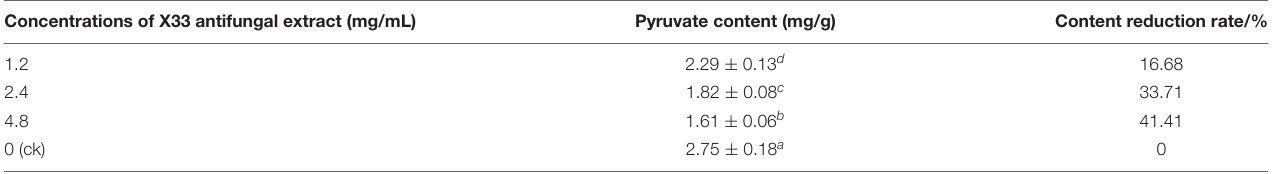
TABLE 2 | Effect of various concentrations of antifungal extract from S. lavendulae strain X33 on pyruvate contents in P. digitatum. Concentrations of X33 antifungal extract